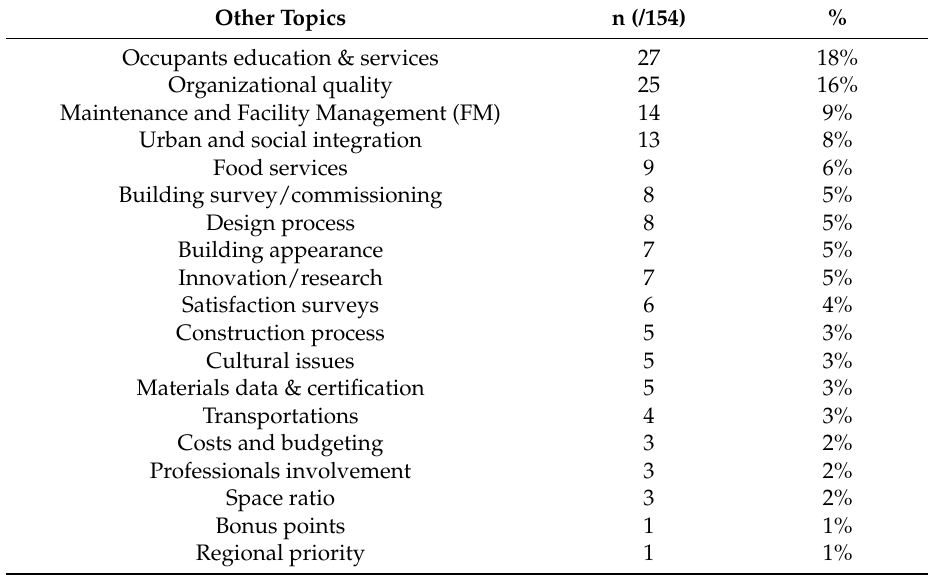
Table 12. Number and percentage of indicators grouped according to Other